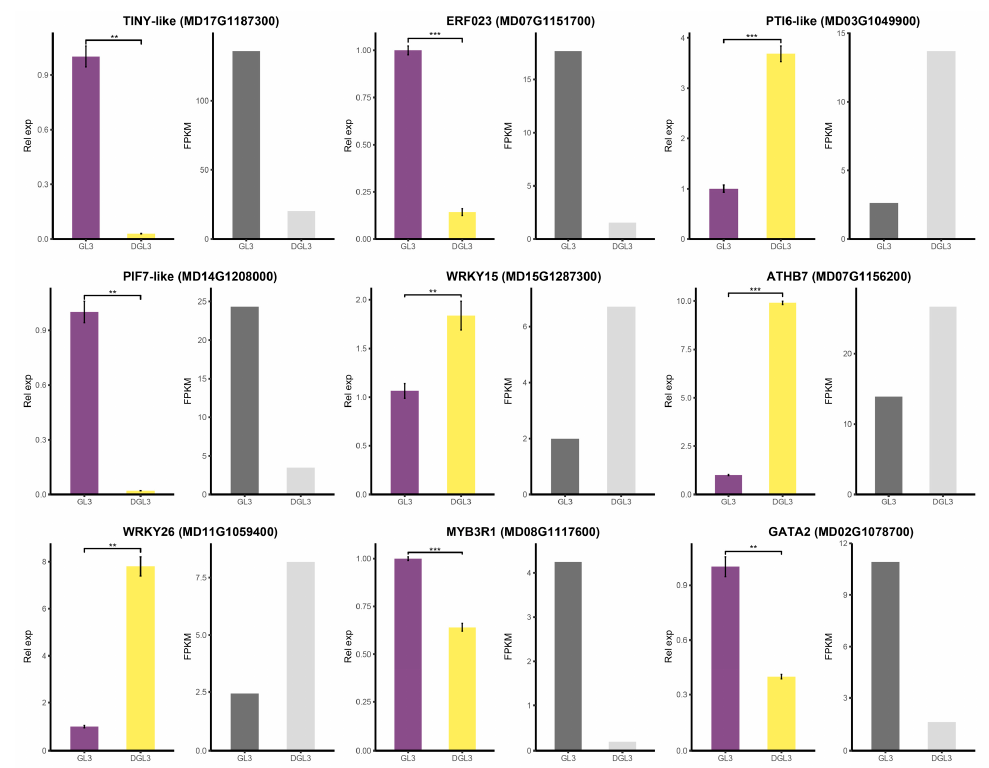
Figure 8. Relative expression of differentially expressed transcription factors measured by RT-qPCR and RNA-seq. The RT-qPCR and RNA-seq result of seven differential transcription factors with dif- ferential chromatin accessibility motifs and two PEIGs. The significance of comparisons was deter- mined by Student’s t -test. Under each gene ID, the left figure shows RT-qPCR and the right figure shows RNA-seq results. ’**’ at 0.01 level. ‘***’ at 0.01